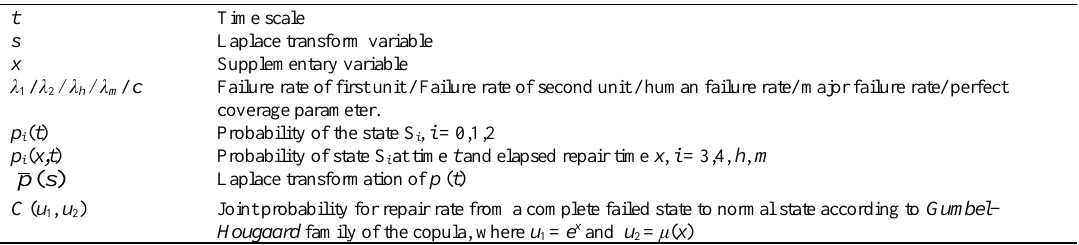
Table 1. Notations.